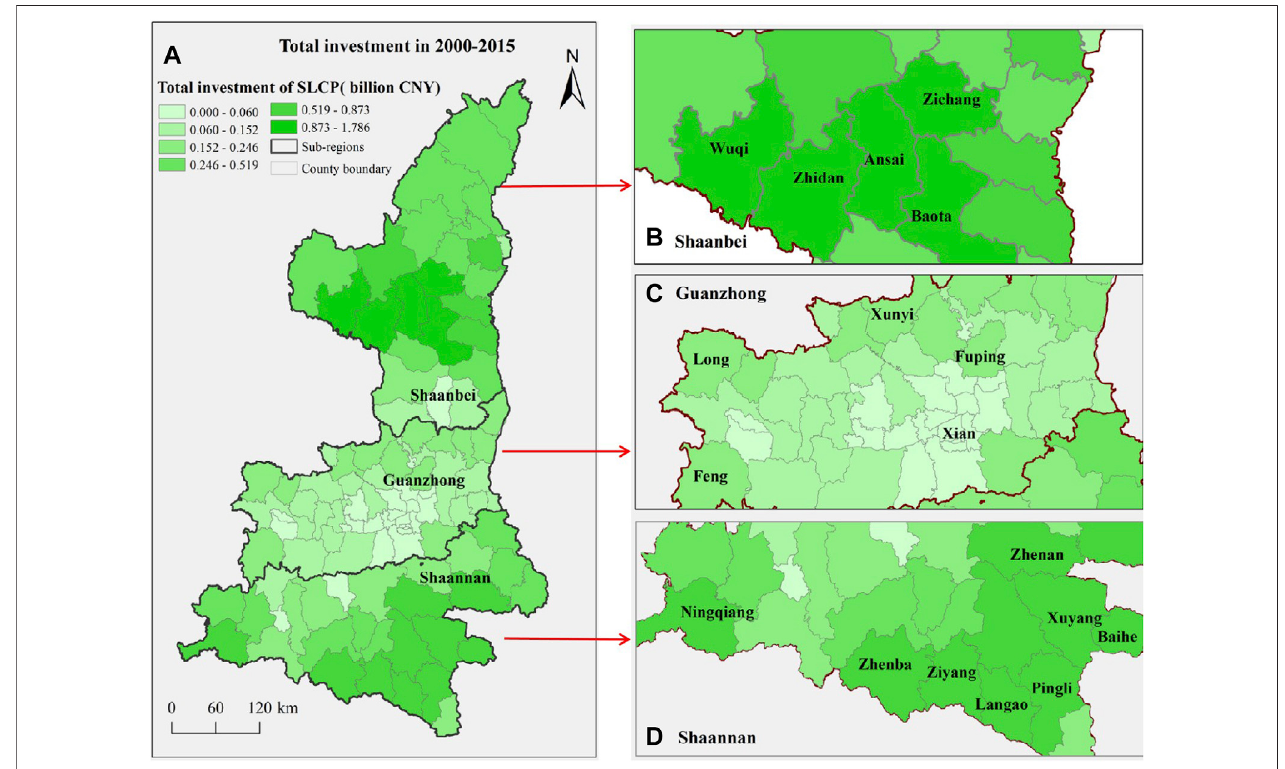
FIGURE 5 | Spatial pattern of the total investment of SLCP in Shaanxi: 2000 – 2015.